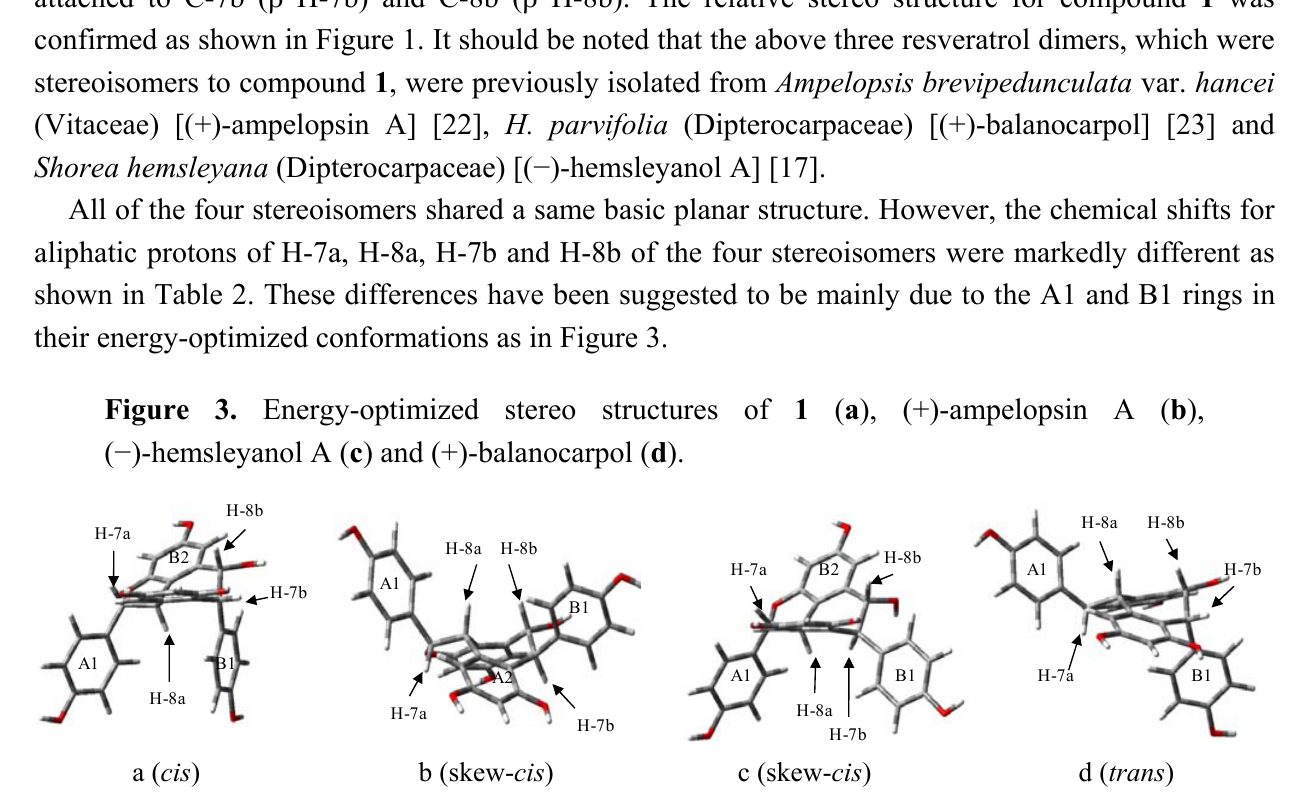
a ( cis ) b (skew- cis ) c (skew- cis ) d ( trans